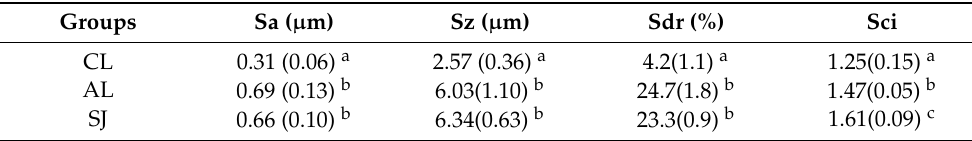
Table 2. Mean values and standard deviations of the surface roughness parameters tested. Same superscripts indicate mean values with no statistically significant differences per parameter ( p > 0.05).